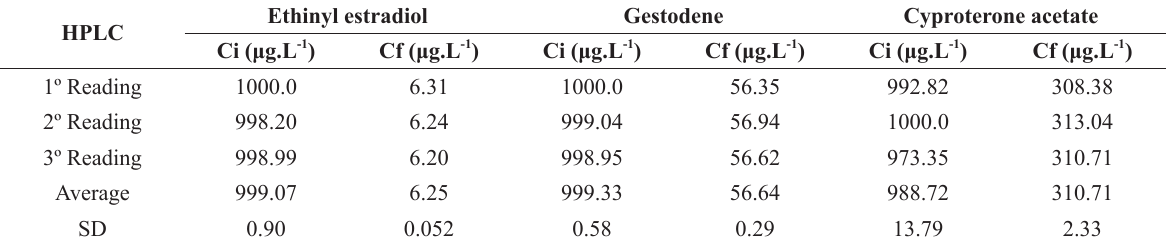
Chromatographic quantitative results for mixture of gestodene, ethinyl estradiol and cyproterone acetate before (Ci) and after (Cf) by the CHT removal reactor.